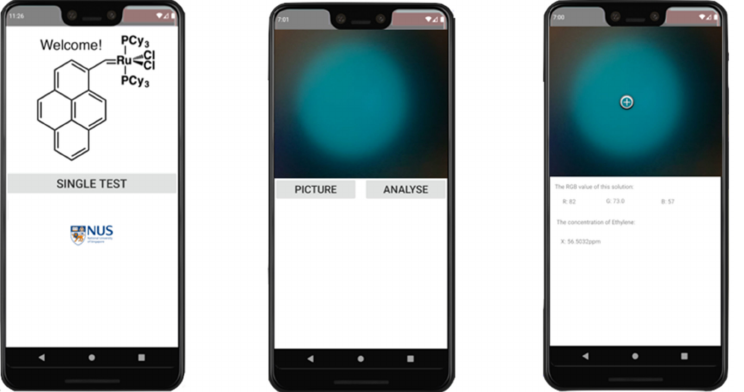
Figure 3. User interface of the android-based application with two functions: photo retrieval and RGB